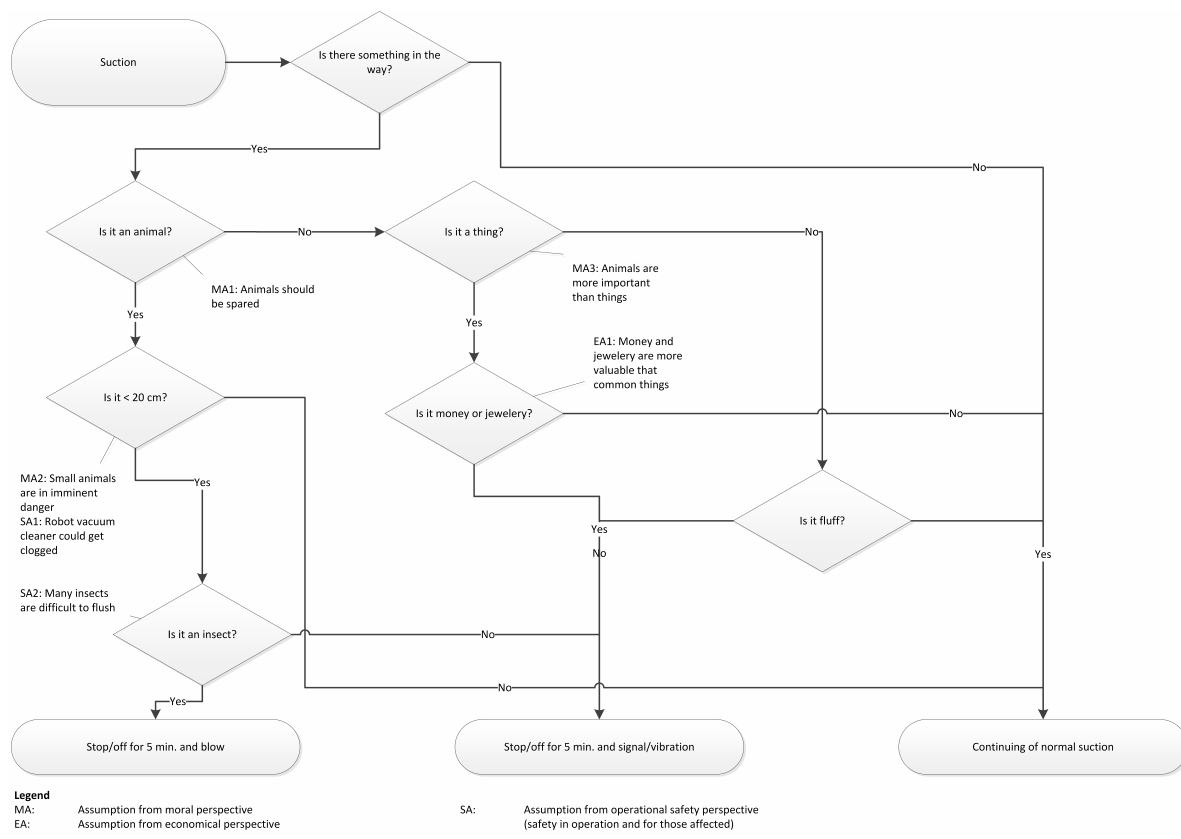
Figure 3: Annotated decision tree for an animal-friendly vacuum cleaning robot according to [26].